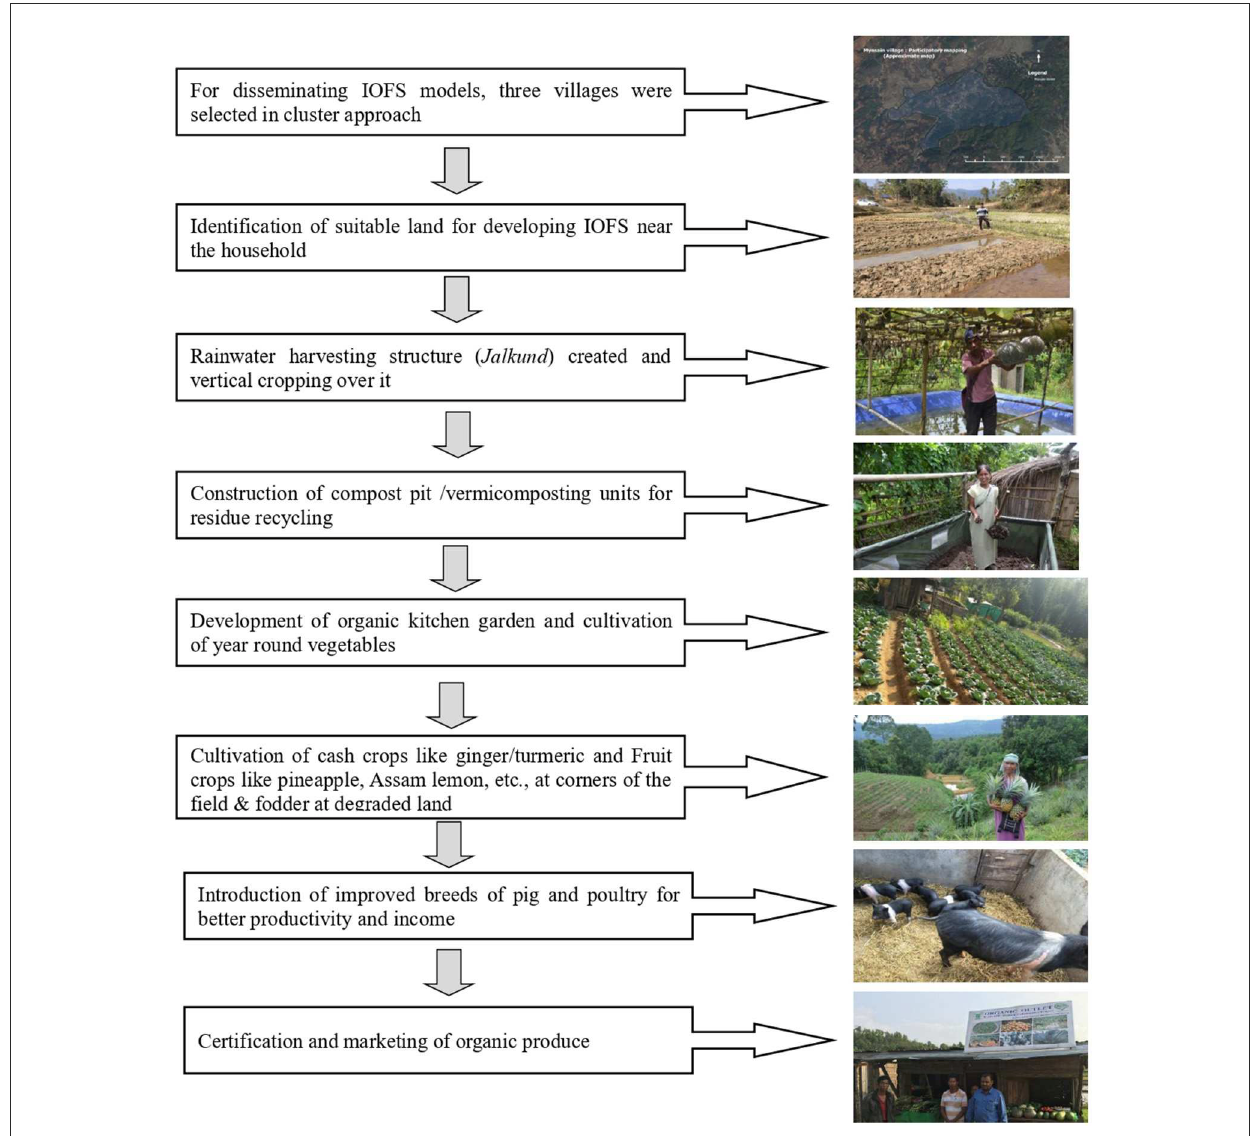
FIGURE2 Flow chart of technology development in an IOFS model.